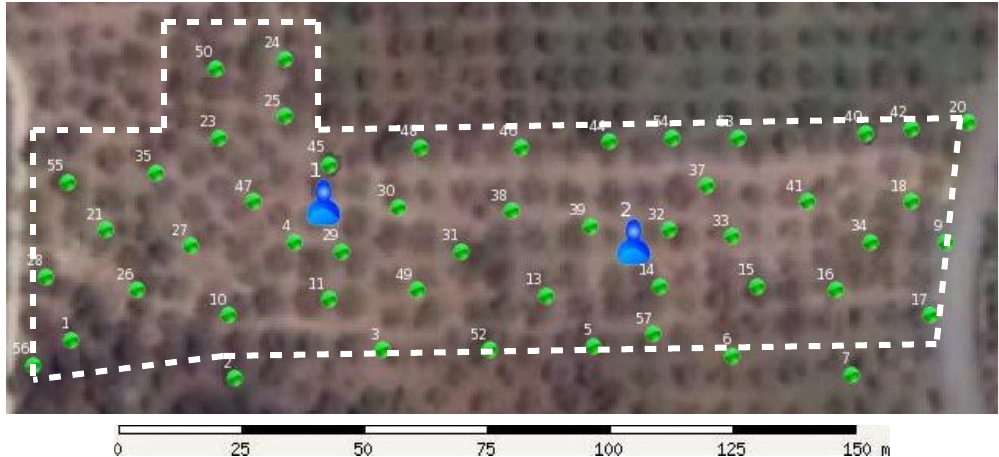
Figure 6. The test field is about is about 195 × 45 m (main body). Trees appear as darker spots on the light-colored soil. There are two gateways and 50 sensor nodes (round dots; some are placed outside the field due to GPS positioning